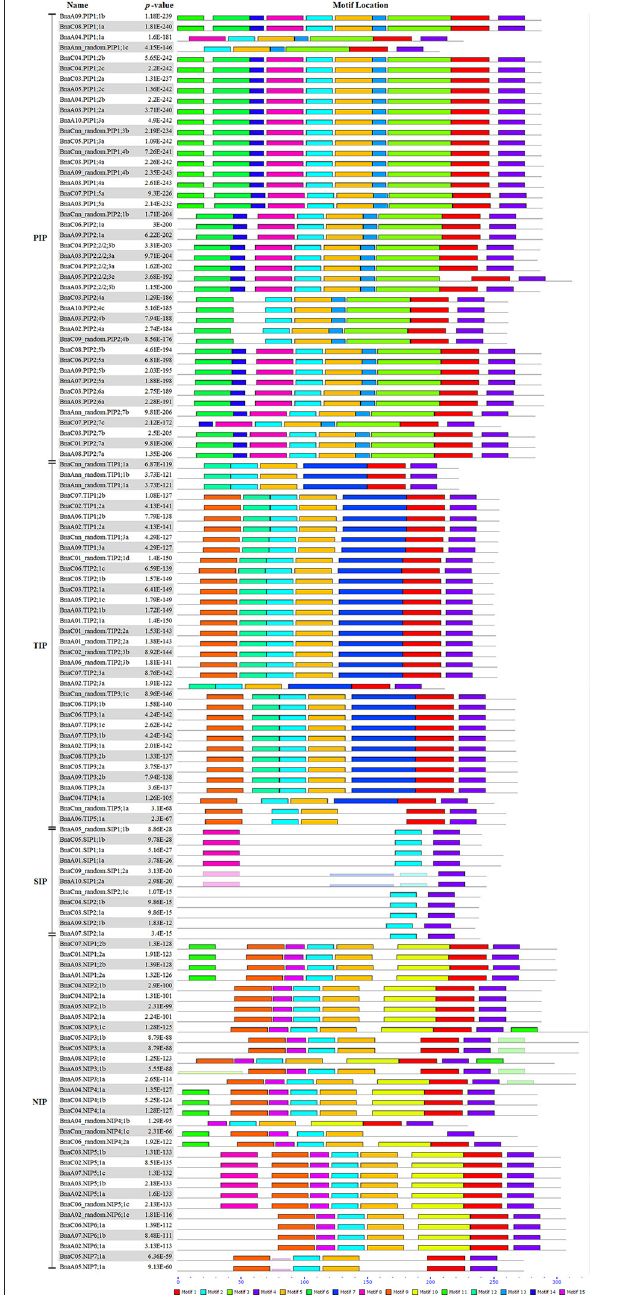
FIGURE 4 | Distribution of conserved motifs in BnaAQP s. Conserved motifs of BnaAQP s were analyzed by MEME Web serve using the protein sequences of 121 full-length BnaAQP s. Fifteen conserved motifs were identified, and different motifs were distinguished by different colors.